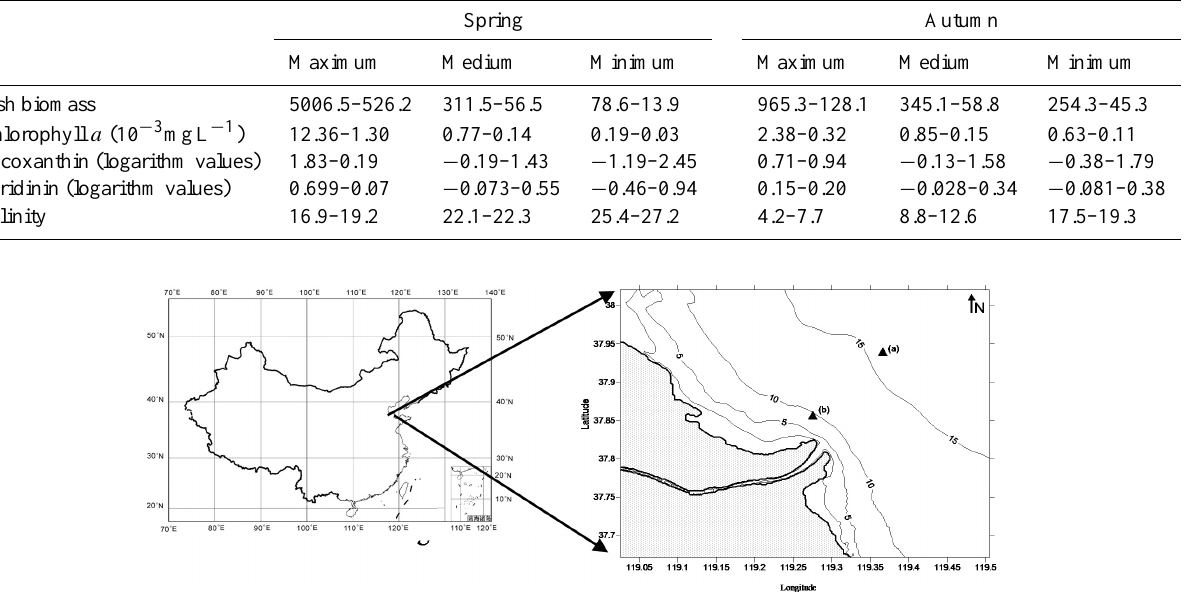
Table 1. Ecological measures in the Yellow River estuary (diagnostic pigments).